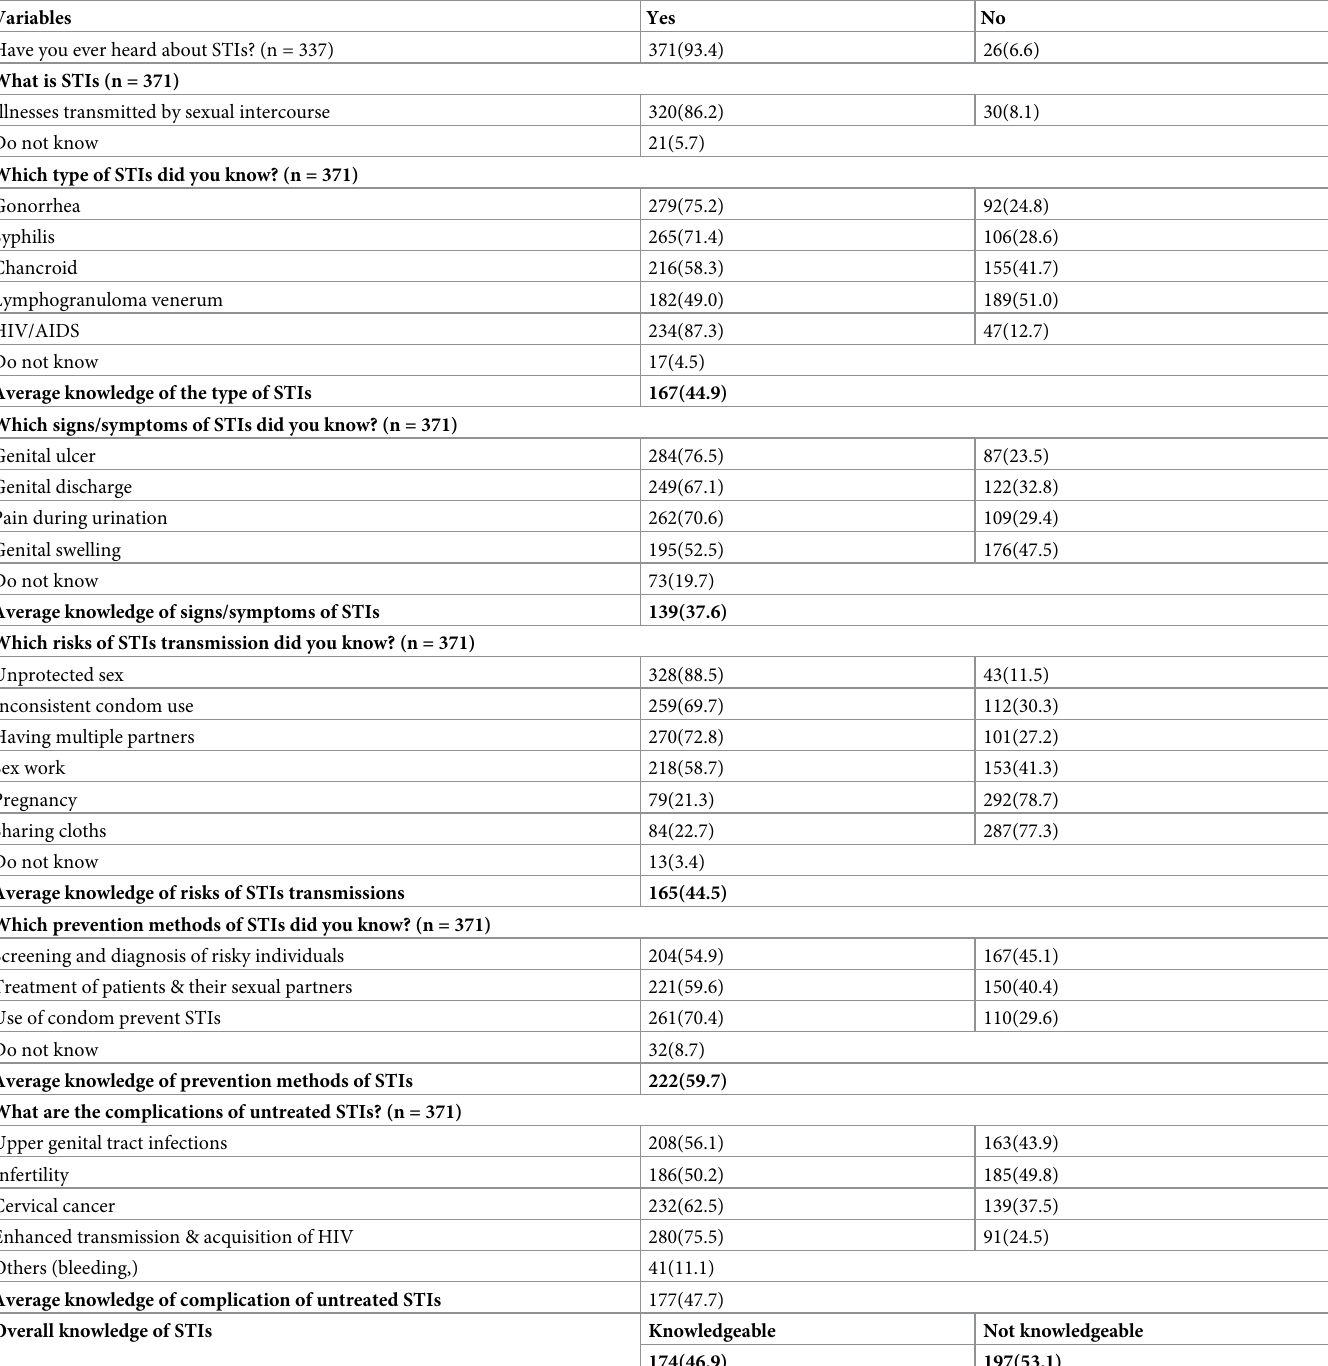
Table 5. The respondents’ knowledge of STIs in North-shewa zone, Ethiopia, 2019.